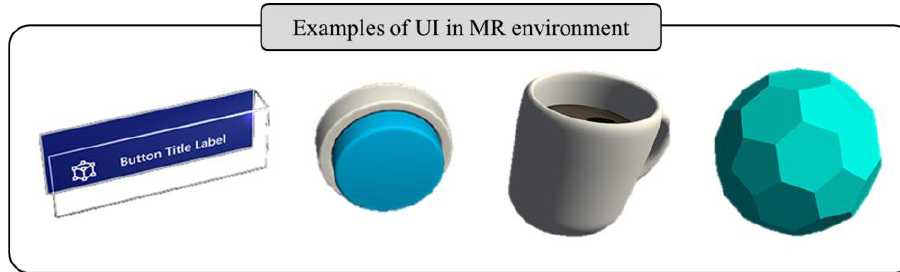
Figure 1. Examples of UI in MR environment.